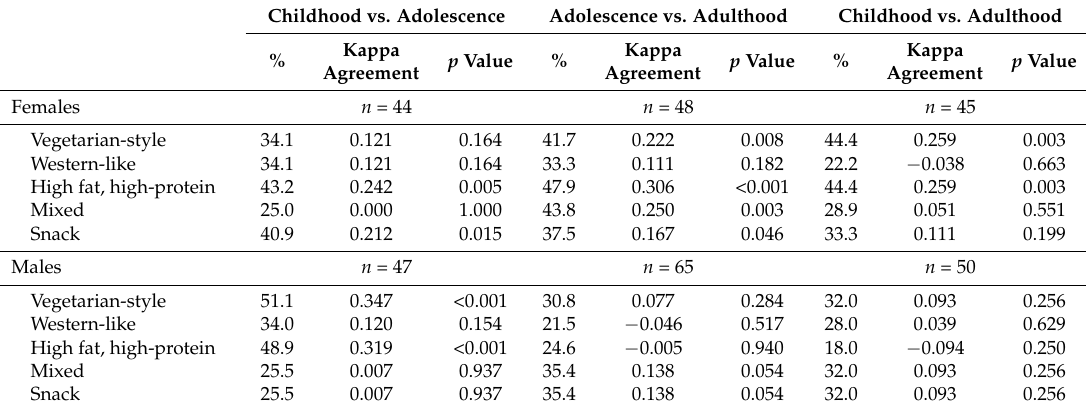
Table 5. Proportion (%) of participants remaining in the same quartile for dietary pattern score from childhood to young adulthood in total